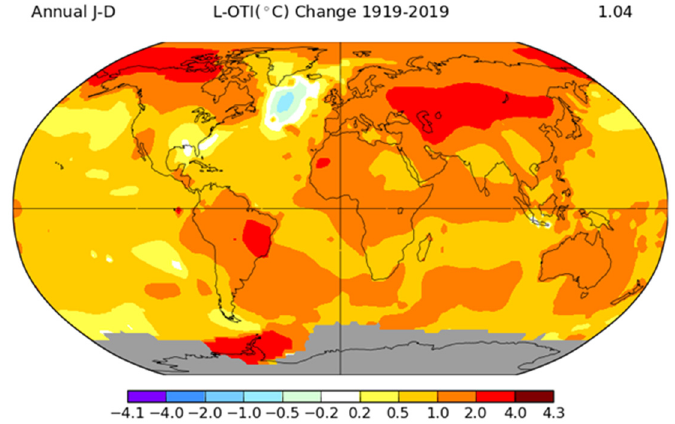
Figure 1. Temperature change ( ◦ C) in 2019 compared with the year 1919. Note: grey areas signify missing data (source: figure taken from https://data.giss.nasa.gov/gistemp/ and adapted for illustrative purpose only).